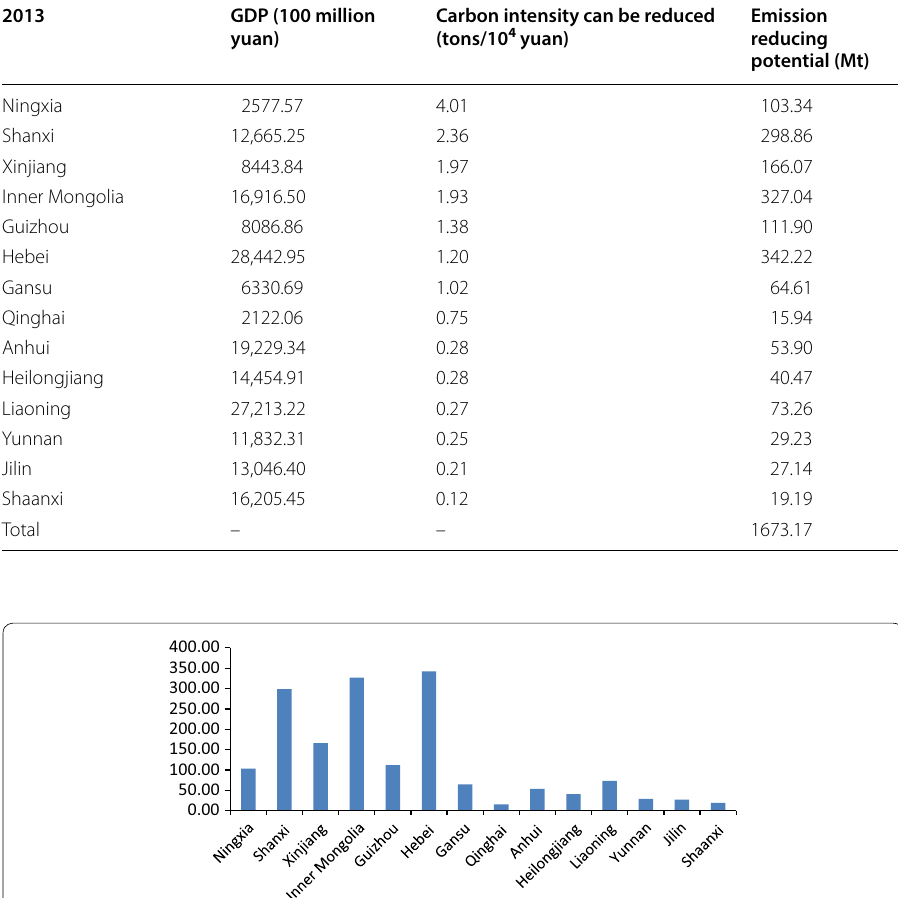
Emission reducing potential (Mt)